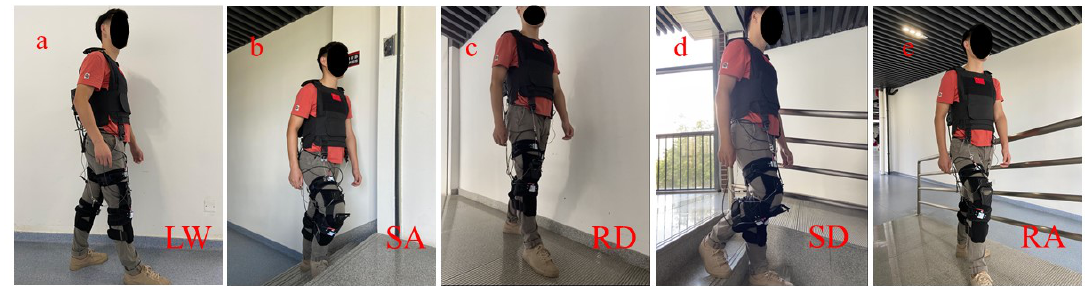
Figure 8. The testers wear a flexible lower-limb exoskeleton to test the continuous terrain motion recognition. ( a ) LW (Level ground walking), ( b ) SA (Stair ascent), ( c ) SD (Stair descent), ( d ) RA (Ramp ascent), ( e ) RD (Ramp